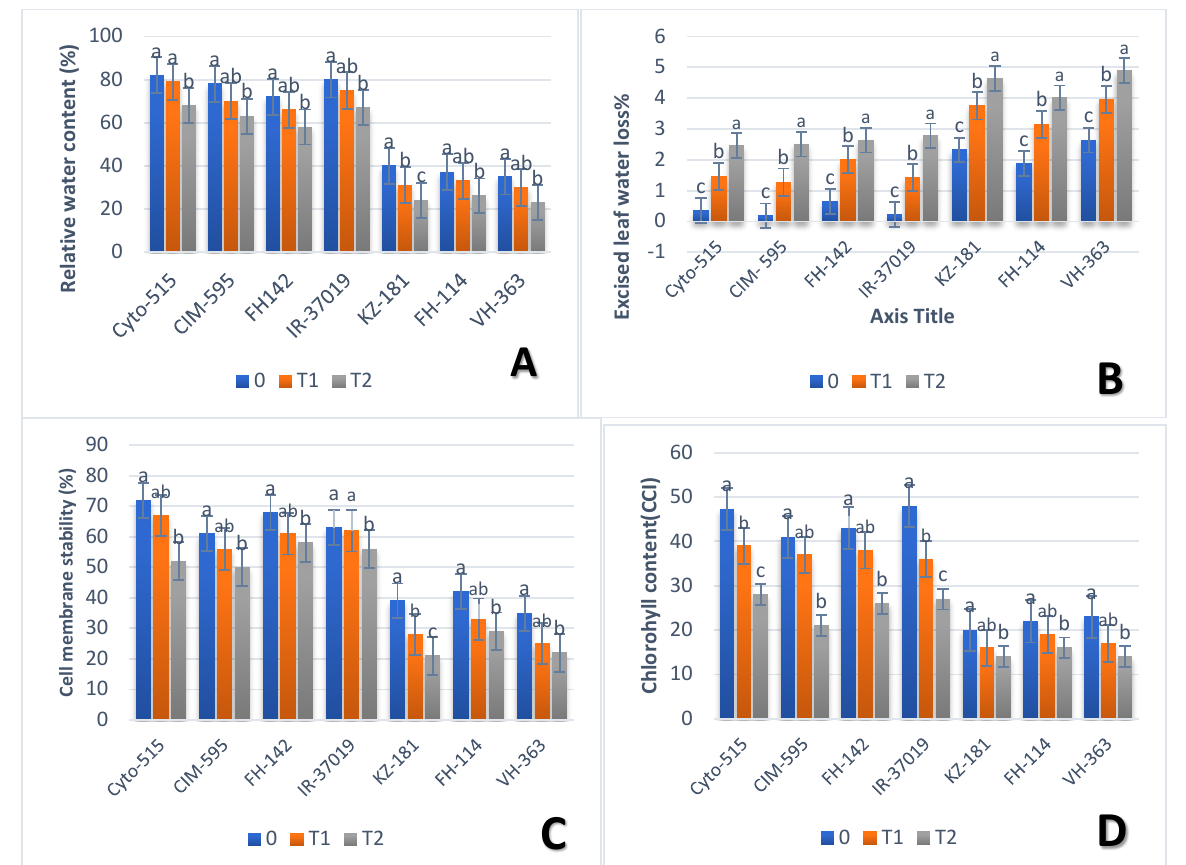
Figure 4. Effect of drought stress on physiological traits of drought-tolerant and susceptible geno- types of cotton ( A ) Relative water content, ( B ) Excised leaf water loss, ( C ) Cell membrane stability, ( D ) Chlorophyll content. Treatments: T0 = Control, T1 = 75% water stress, T2 = 50% water stress showed and bars with the different lettering showed significant differences while the same lettering bars showed non-significant differences between these